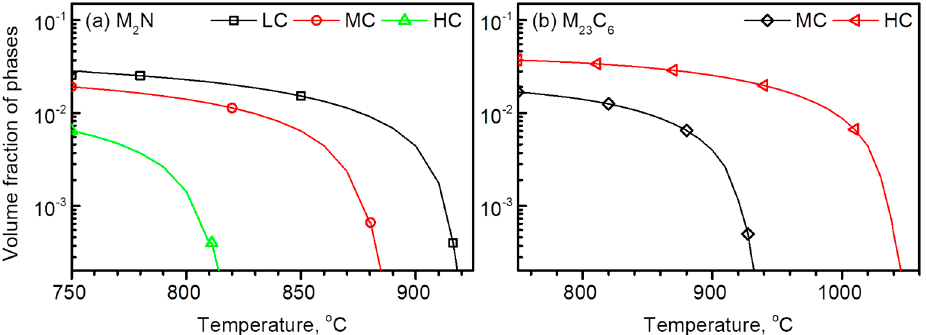
Figure 2. Equilibrium volume fractions of ( a ) M 2 N and ( b ) M 23 C 6 in the LC, MC, and HC alloys as a function of temperature calculated using Thermo-Calc software.